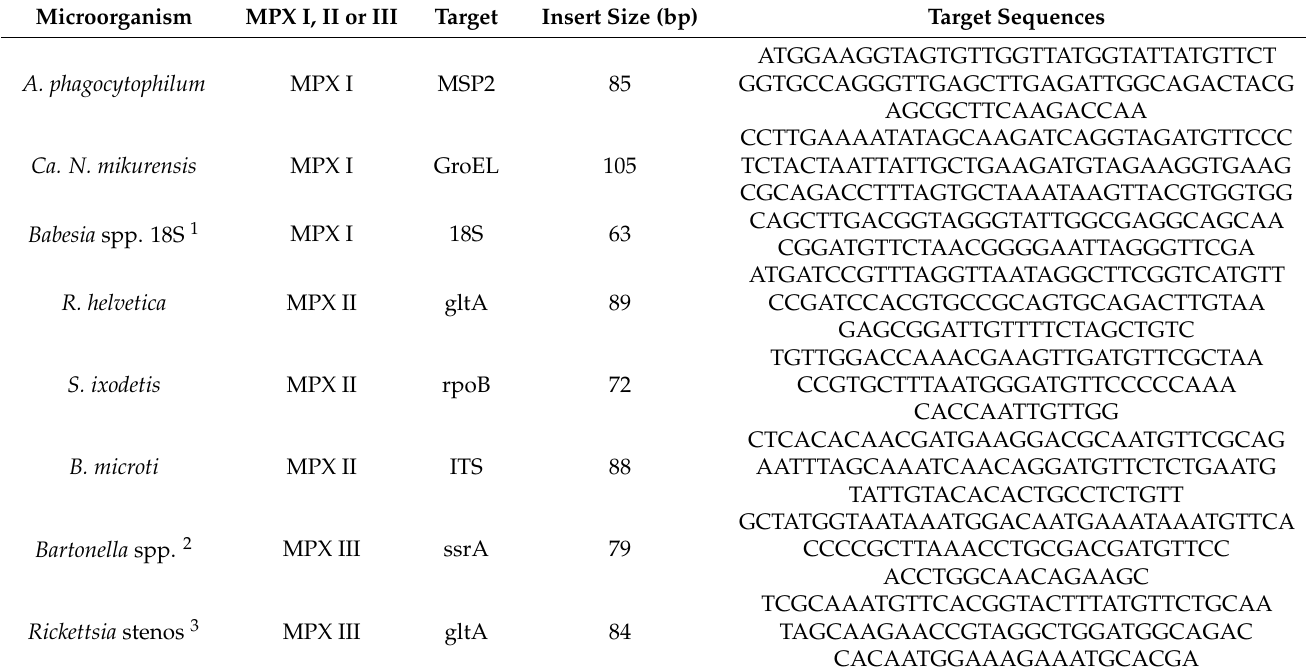
Table 1. Plasmid sequences used for determining the sensitivity of all PCR assays.